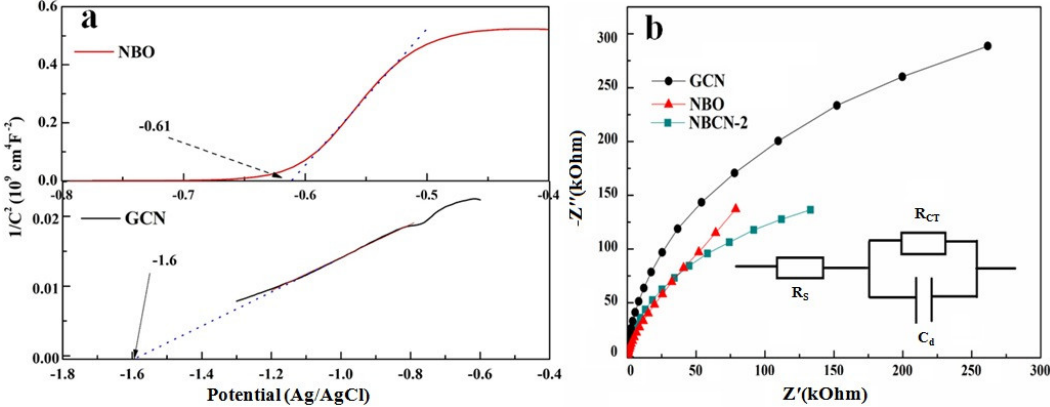
Figure 9. ( a ) Mott–Schottky plot for NBO and GCN at 1000 Hz vs. Ag/AgCl, ( b ) EIS analysis for NBO, GCN and NBCN‐2.